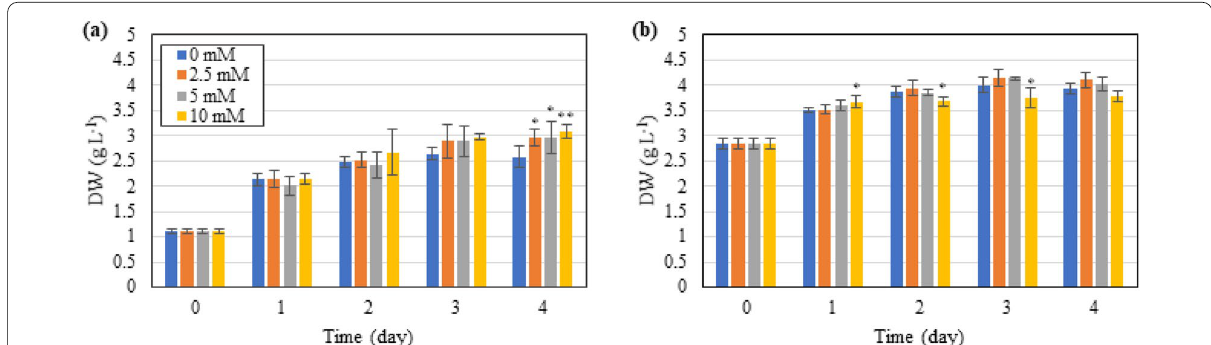
Fig. 1 Effect of exogenous GABA supply on biomass accumulation in T. subcordiformis exposed to nitrogen deprivation under NICD ( a ) and HICD ( b ). * and ** denote the significant differences at p < 0.1 and p < 0.05 levels, respectively, under different GABA conditions (2.5–10 mM) compared to those under 0 mM GABA (means SD, n 3) ± =